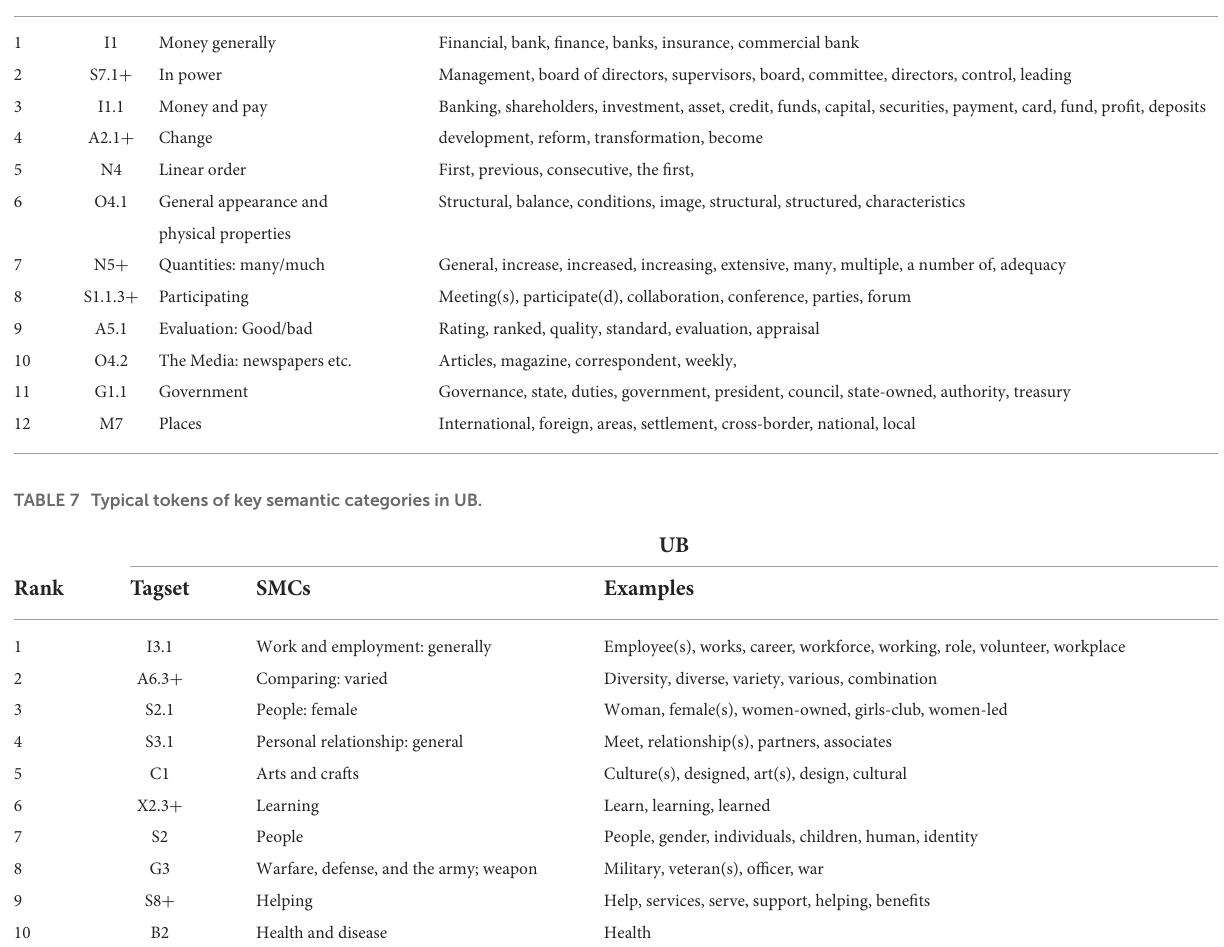
TABLE 6 Typical tokens of key semantic categories in CB.